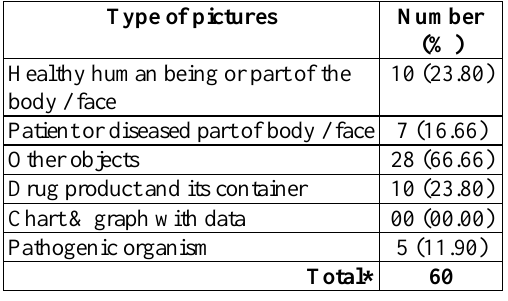
Table IV : Analysis of pictorial elements in drug